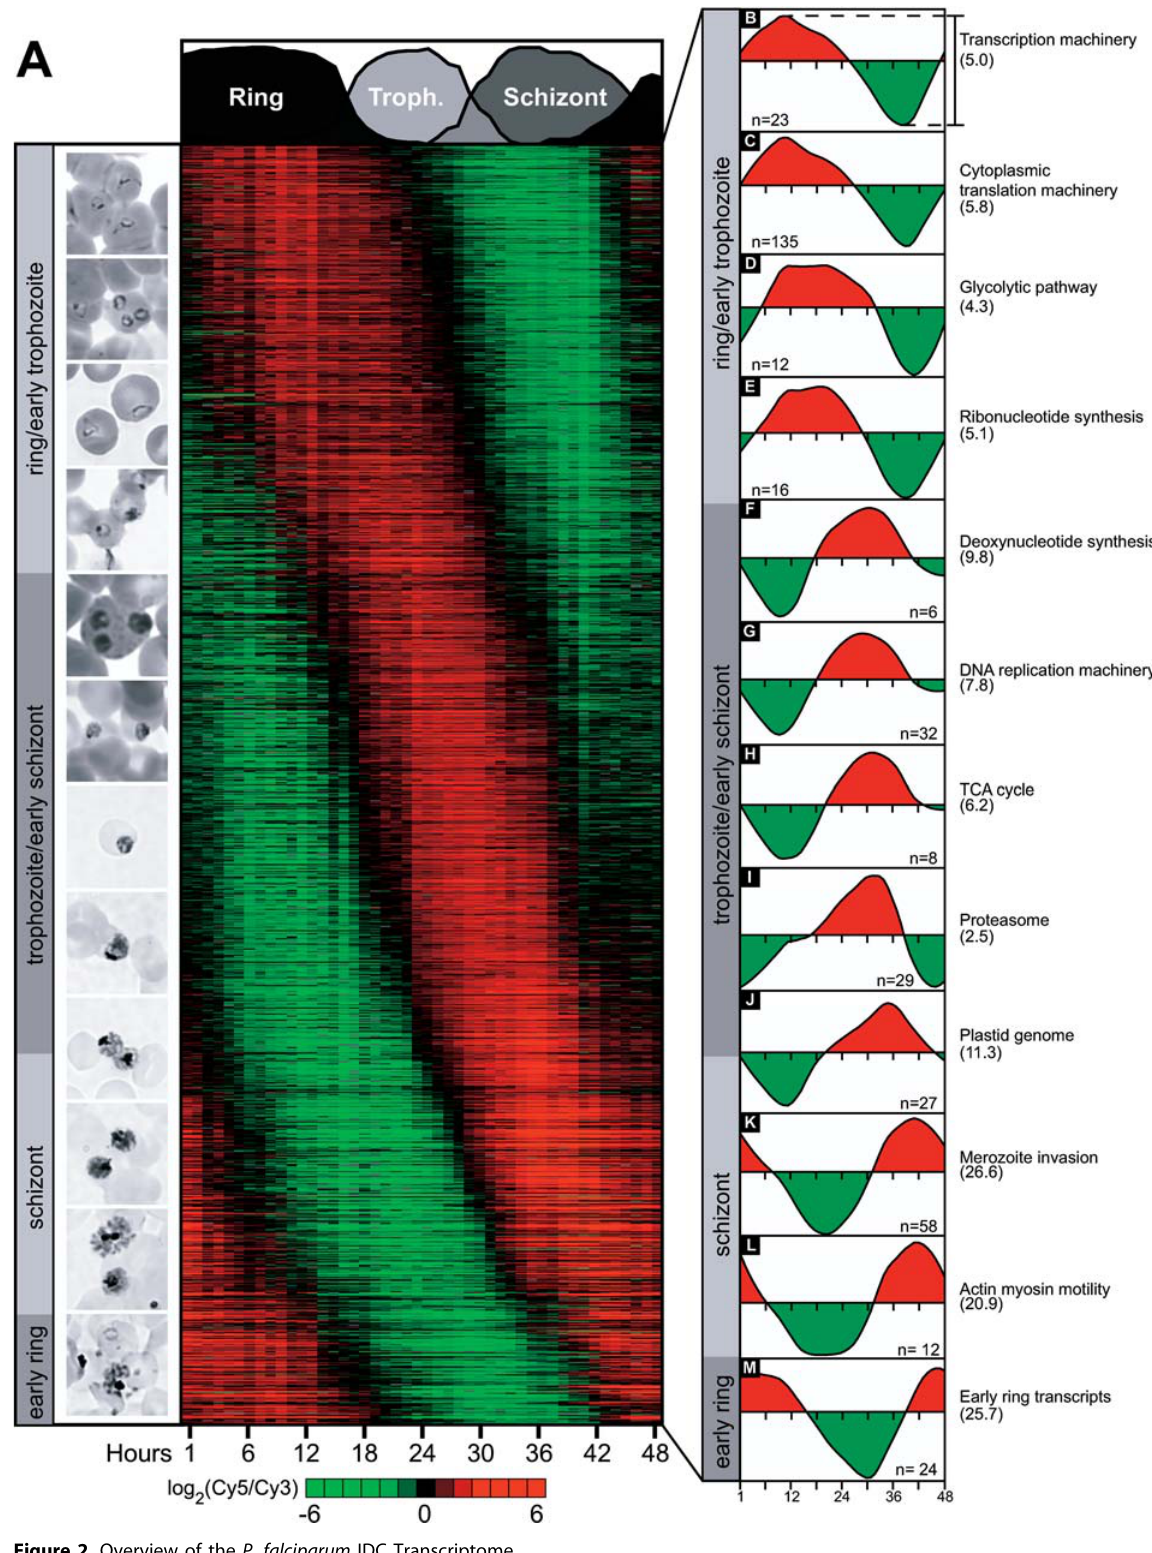
Figure 2. Overview of the P. falciparum IDC Transcriptome (A) A phaseogram of the IDC transcriptome was created by ordering the transcriptional profiles for 2,712 genes by phase of expression along the y-axis. The characteristic stages of intraerythrocytic parasite morphology are shown on the left, aligned with the corresponding phase of peak gene expression. (B–M) The temporal ordering of biochemical processes and functions is shown on the right. Each graph corresponds to the average expression profile for the genes in each set and the mean peak-to-trough amplitude is shown in parentheses. DOI: 10.1371/journal.pbio.0000005.g002 PLoS Biology | http://biology.plosjournals.org Volume 1 | Issue 1 | Page